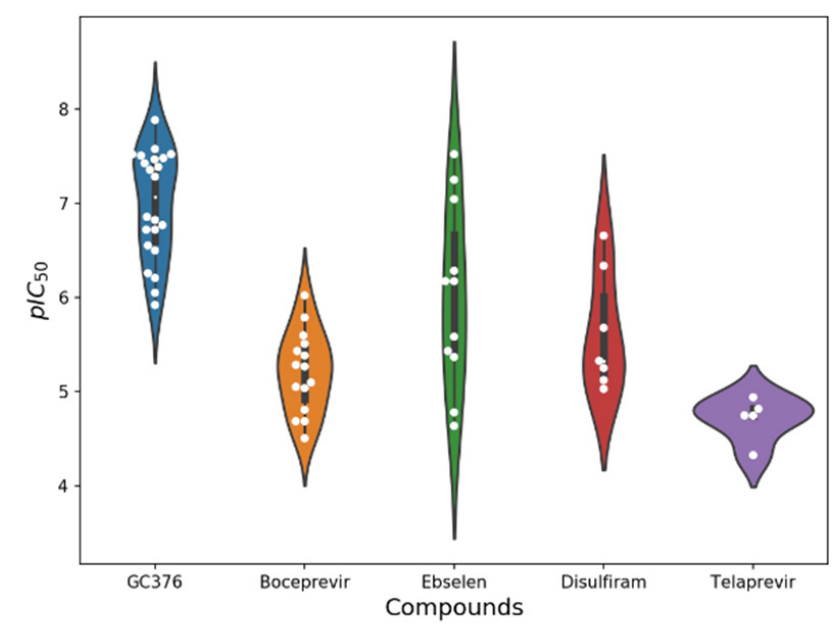
Figure 4. Comparison of multiple pIC 50 values calculated by different laboratories. The pIC 50 values of the five most evaluated compounds, GC376, boceprevir, ebselen, disulfiram and telaprevir, are shown as white points to highlight that different laboratories and methods can estimate different pIC 50 values.